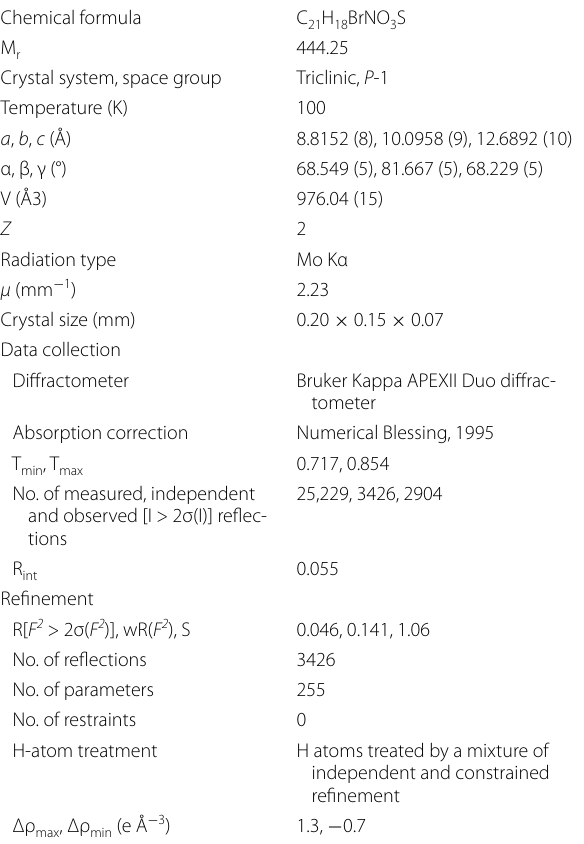
Table 1 Crystal data and structure refinement for 2 Chemical